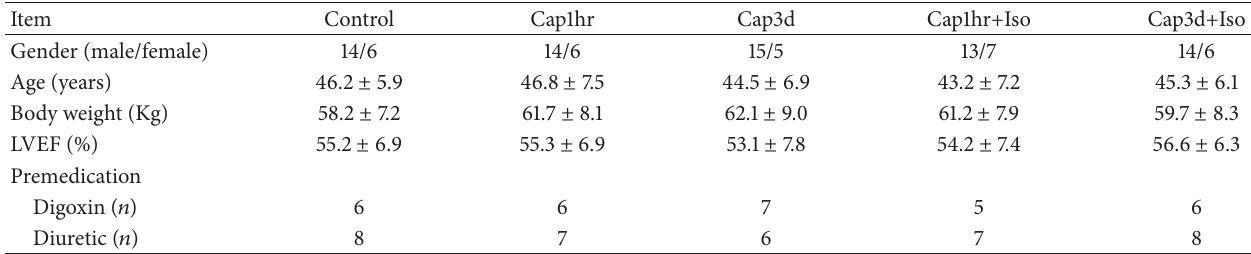
Table 1: Baseline characteristics of the study population.